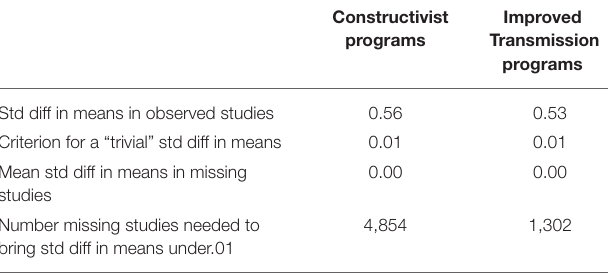
TABLE 4 | Orwin’s fail-safe N